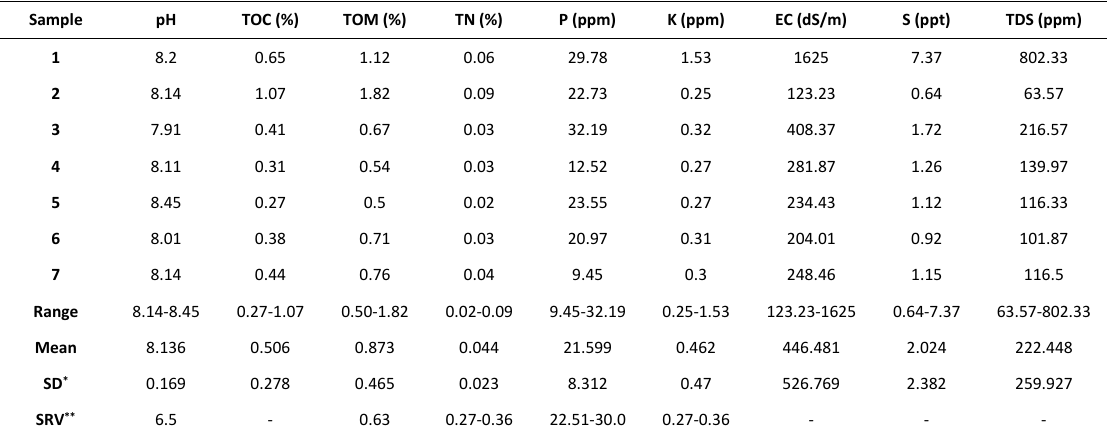
Table 2. Statistical analysis of different soil parameters